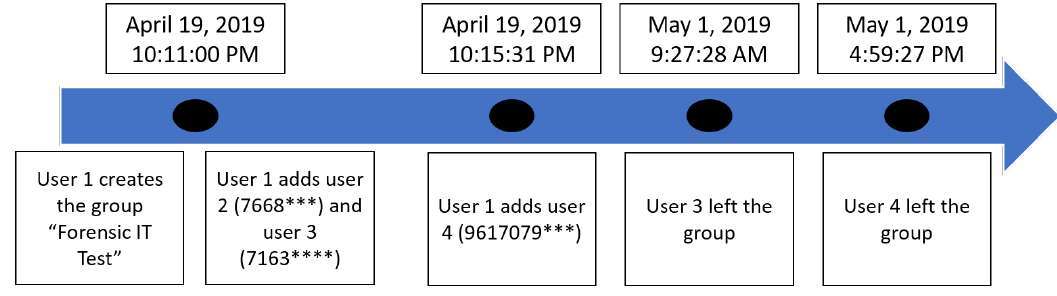
Figure 25. Timeline shows the chronology of the group composition